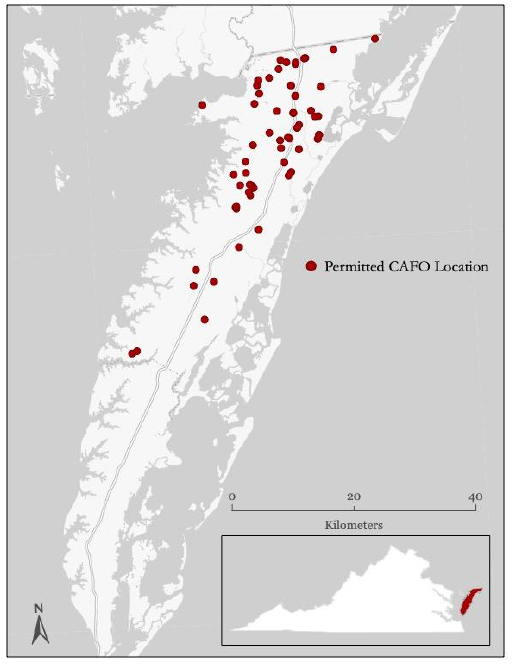
Figure 1. Locations of CAFOs on the Eastern Shore, Virginia